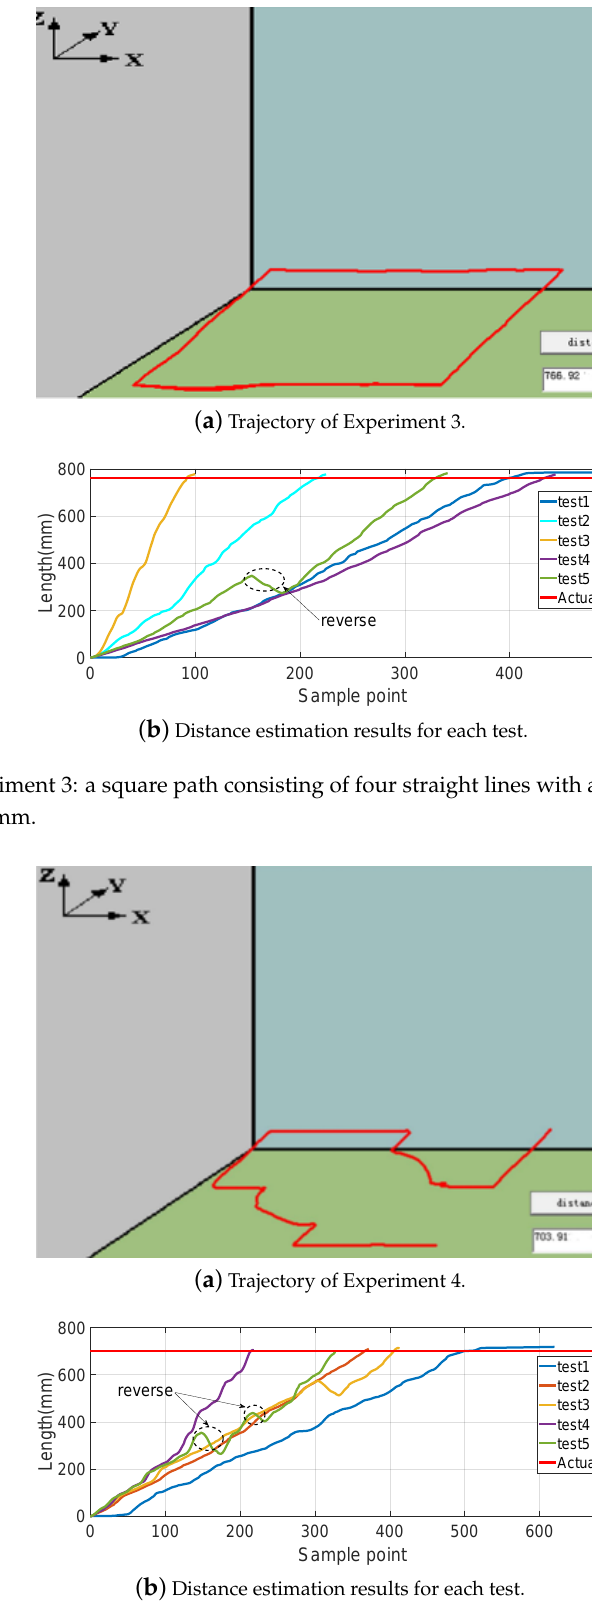
Figure 11. Experiment 4: includes two arcs and several straight lines, total length being 700